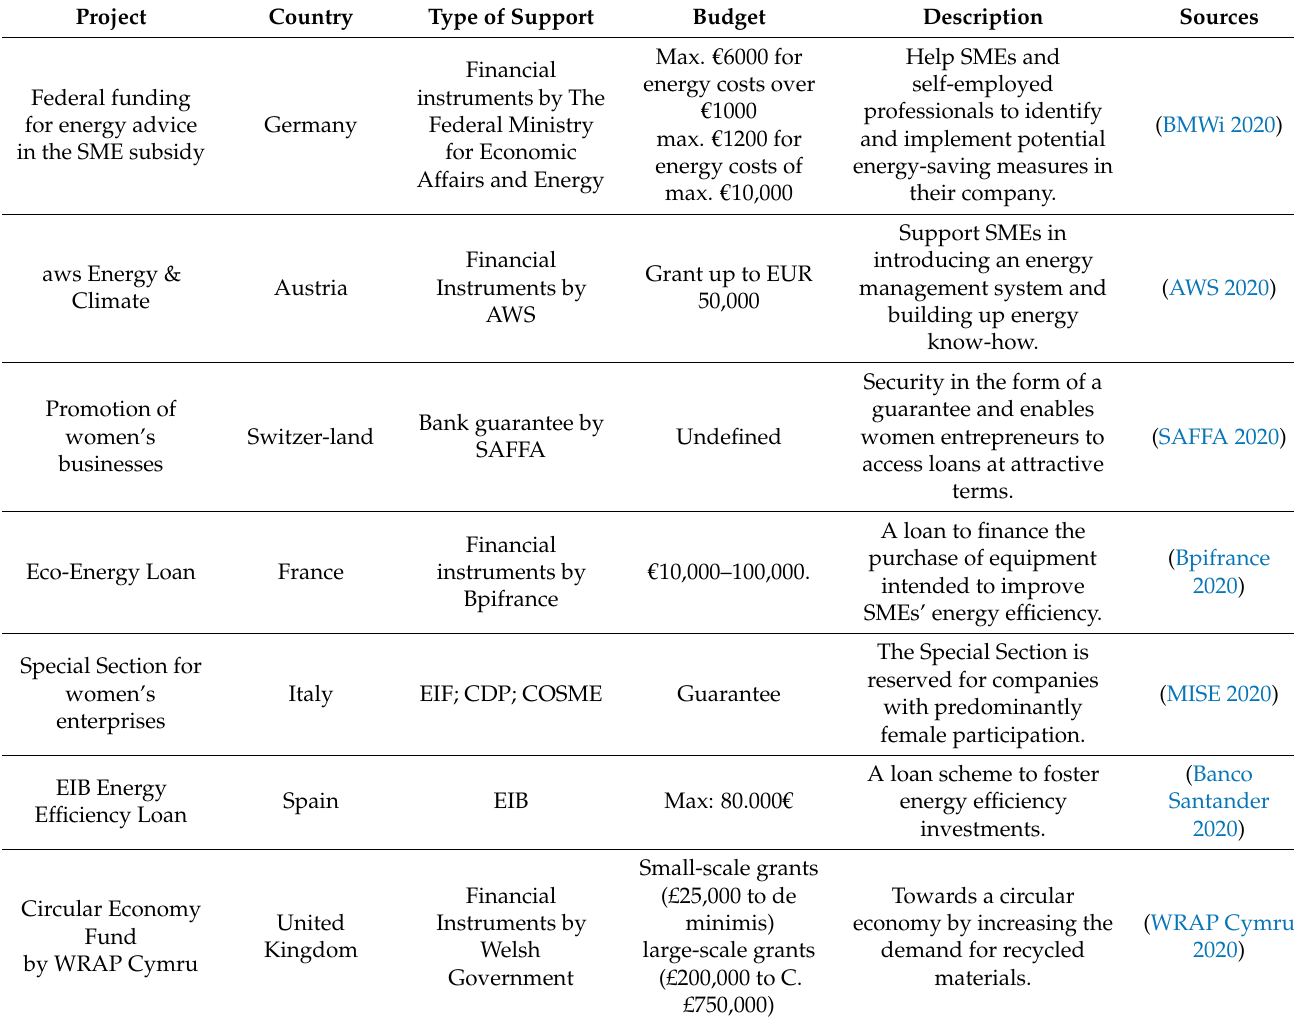
Table 3. Examples of responsible financing projects in